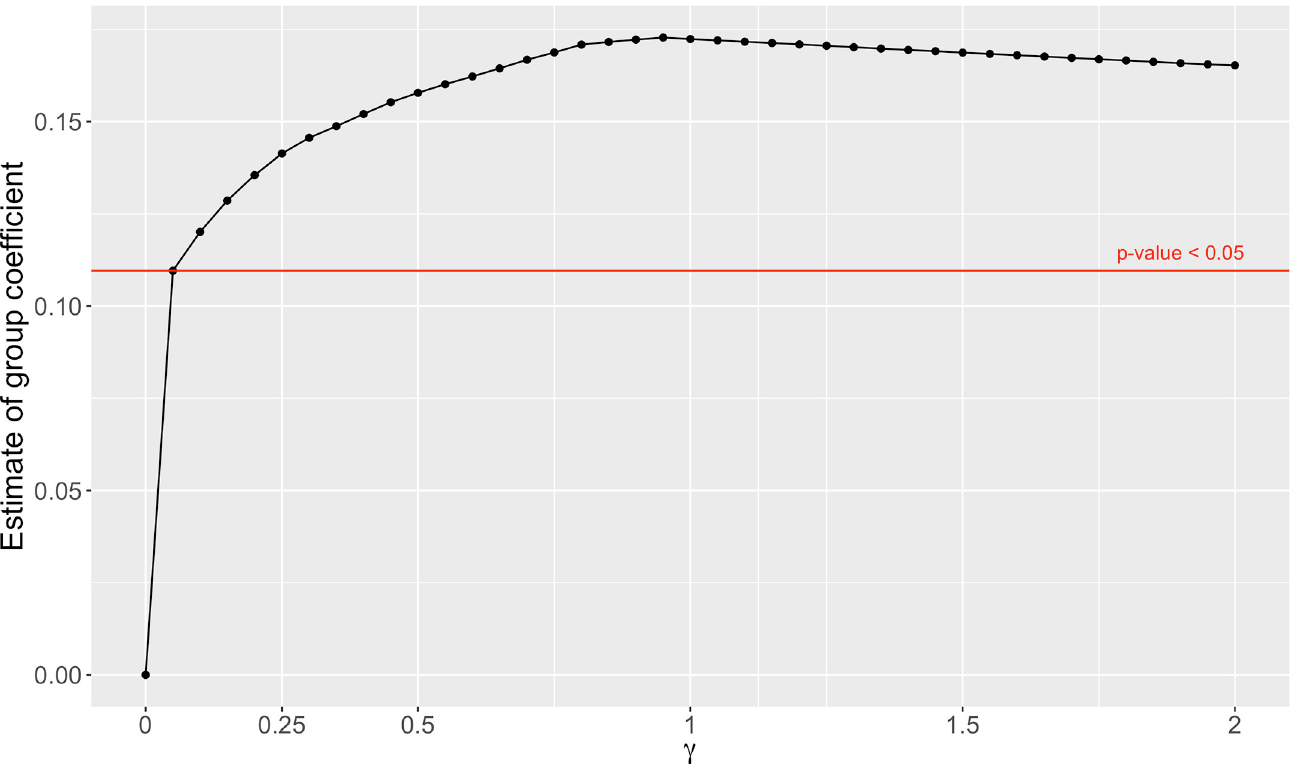
Fig 3. Estimated group coefficient β 1 vs. γ for rTHC . The group coefficient β 1 is estimated at different γ values. Any coefficients above the red line are statistically significant, the red line crosses the curve at the point ð g ¼ 0 : 05 ; ^ b